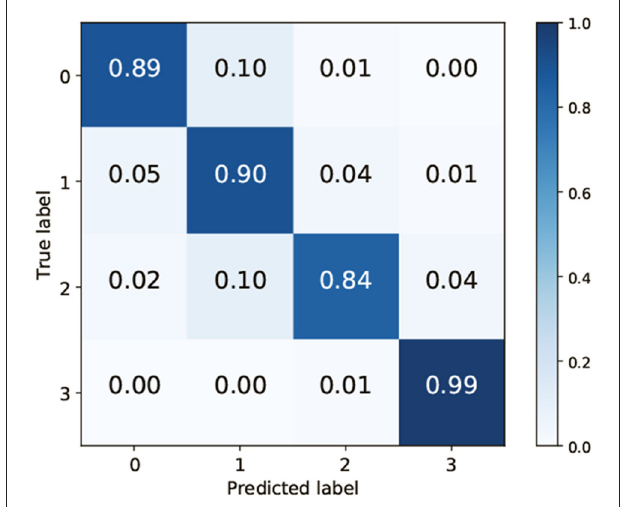
FIGURE 9 | Classification accuracy with increase in percentage of training data.